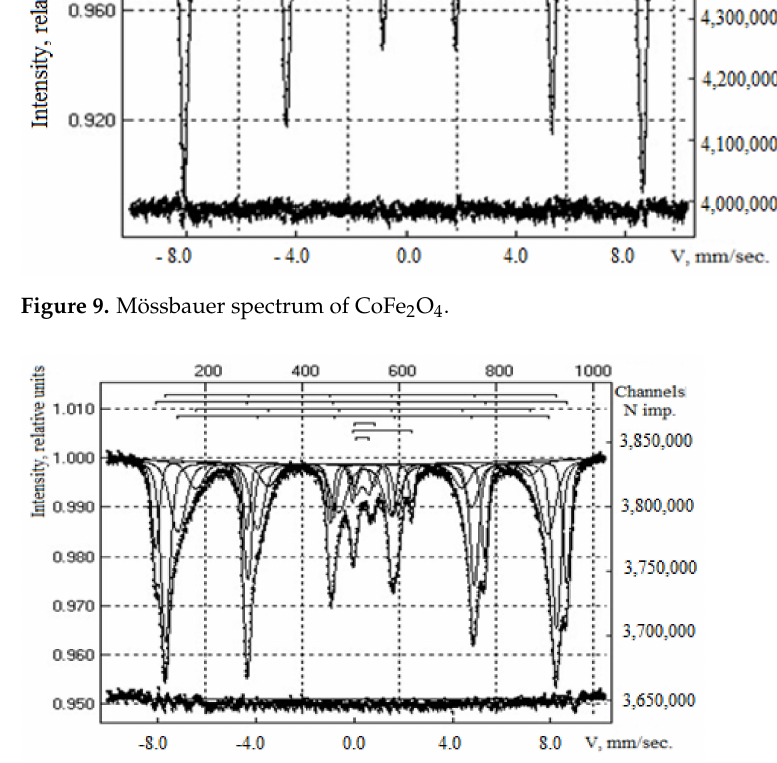
Figure 10. Mössbauer spectrum of CoFe 2 O 4